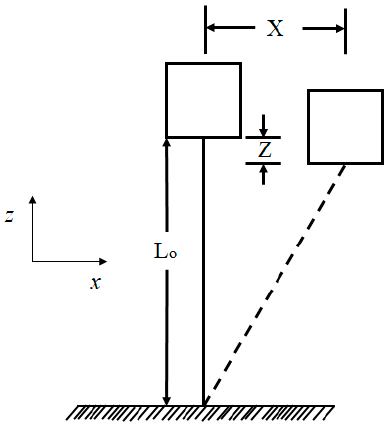
Figure 15. Definition sketch for offset and set-down relationship.